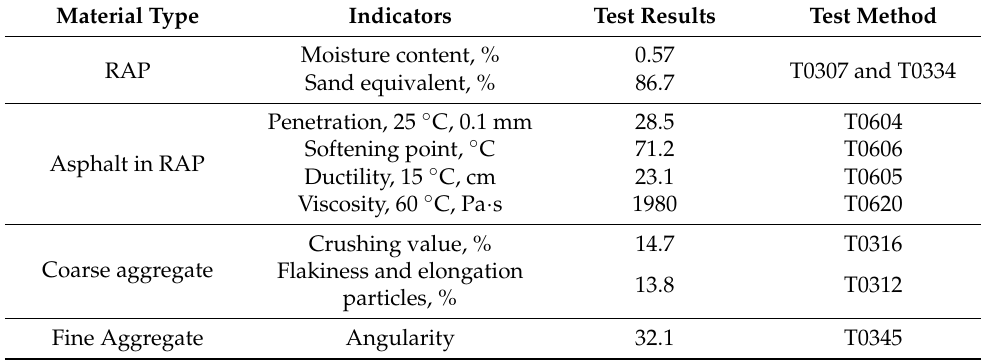
Table 4. Performance indexes of RAP.